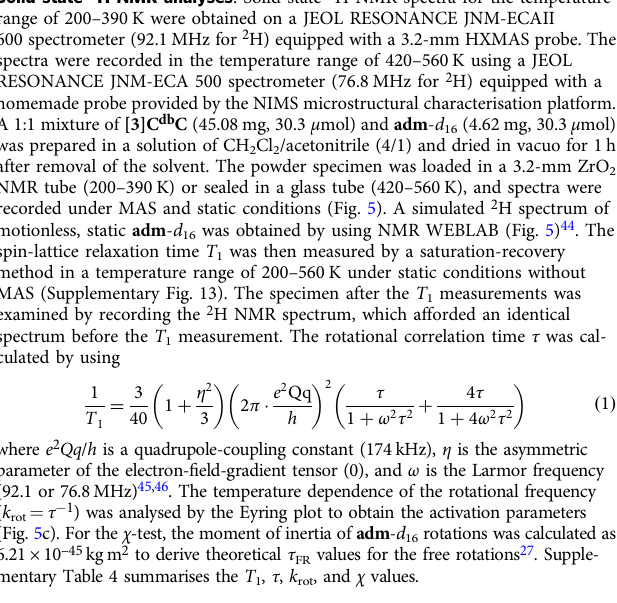
Theoretical calculations . Theoretical DFT calculations of [3]C db C ⊃ adm with a methyl-substituted cylinder as the model were performed with the LC-BLYP functional 40 and the 6-311 G(d) basis set 41 via counterpoise BSSE corrections in Gaussian 16 42 . The AIM analyses were performed with Multiwfn 43 . The global minimum structure at (A,B) = (0,0) was obtained by geometry optimisations using a crystal structure adopted as the initial geometry. The energy pro fi le was obtained by performing single-point energy calculations of 324 (18 × 18) orientations in total by rotating adm 20° along axis A and axis B (Fig. 4). The number of CH – π hydrogen bonds was manually counted for 5184 hydrogen atoms to visualise the hydrogen-bonding sites among the 324 orientations (Supplementary Fig. 12). Solid-state 2 H NMR analyses . Solid-state 2 H NMR spectra for the temperature range of 200 – 390 K were obtained on a JEOL RESONANCE